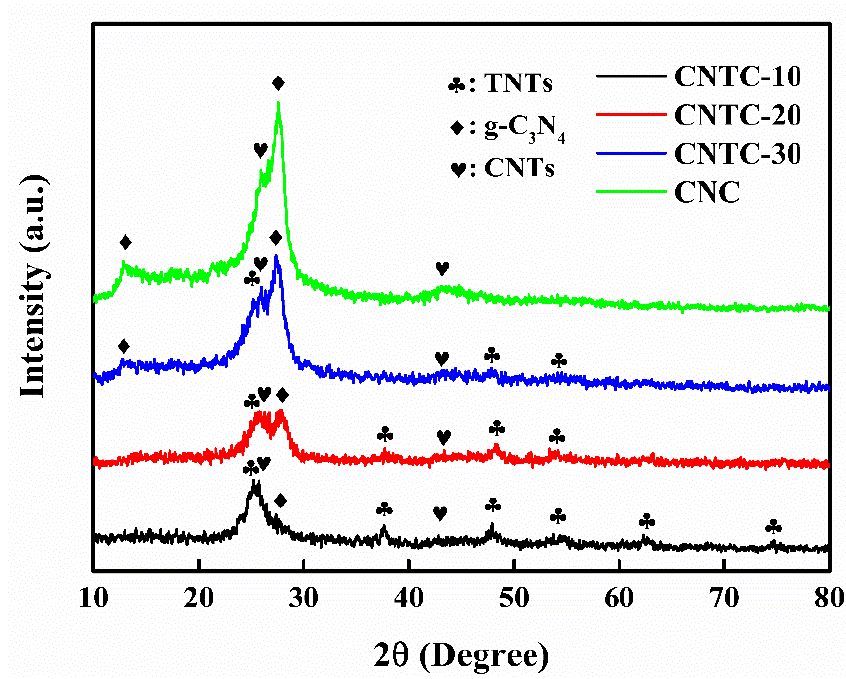
Figure 1. XRD patterns of CNTC and CNC.